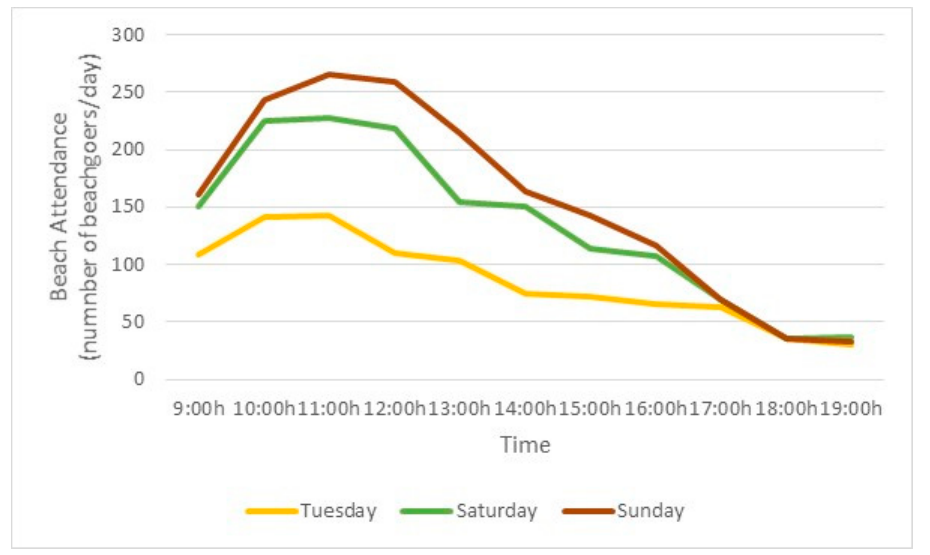
Figure 7. Hourly distribution of beach users for Tuesdays, Saturdays, and Sundays for June, July, and August from 2016 to 2018.